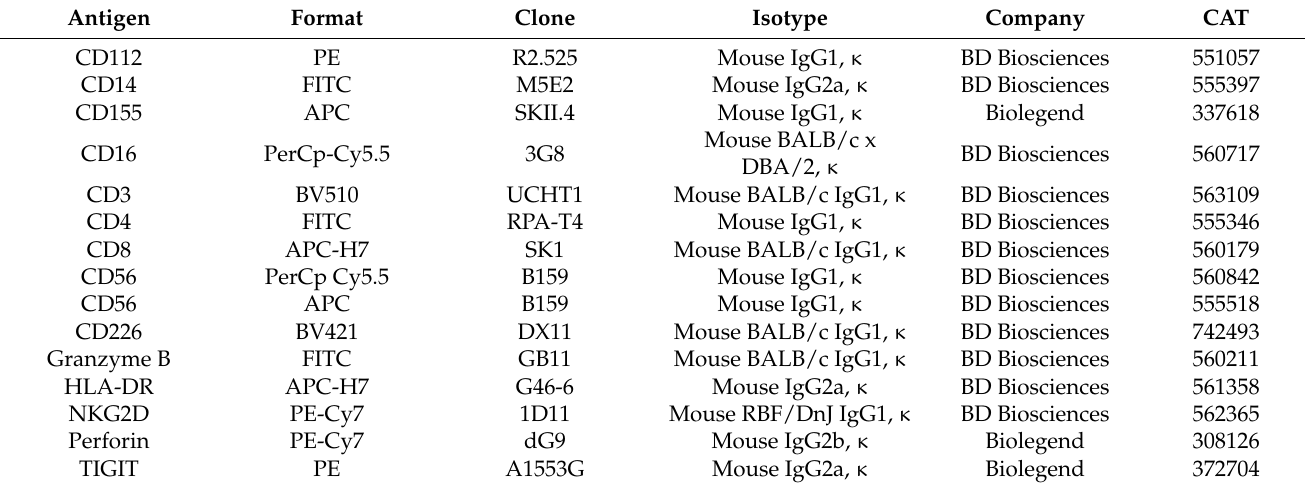
Table 2. Fluorochrome conjugated monoclonal antibodies used in the